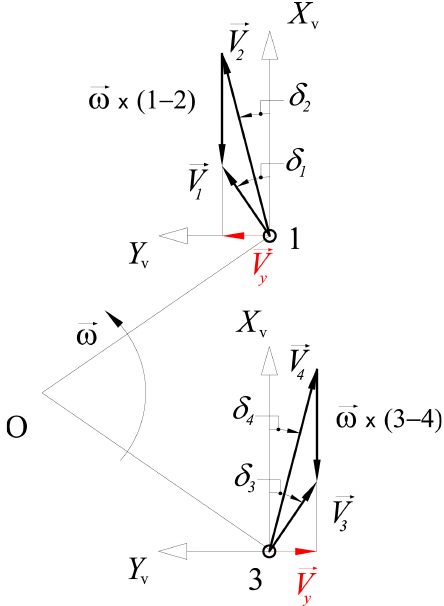
Figure 4. Graphical analysis of the wheel velocities of a rover with symmetric steering. All wheels admit equal lateral velocity components in magnitude. Direction of the lateral velocity components of the front wheel pair is opposite to that of the rear